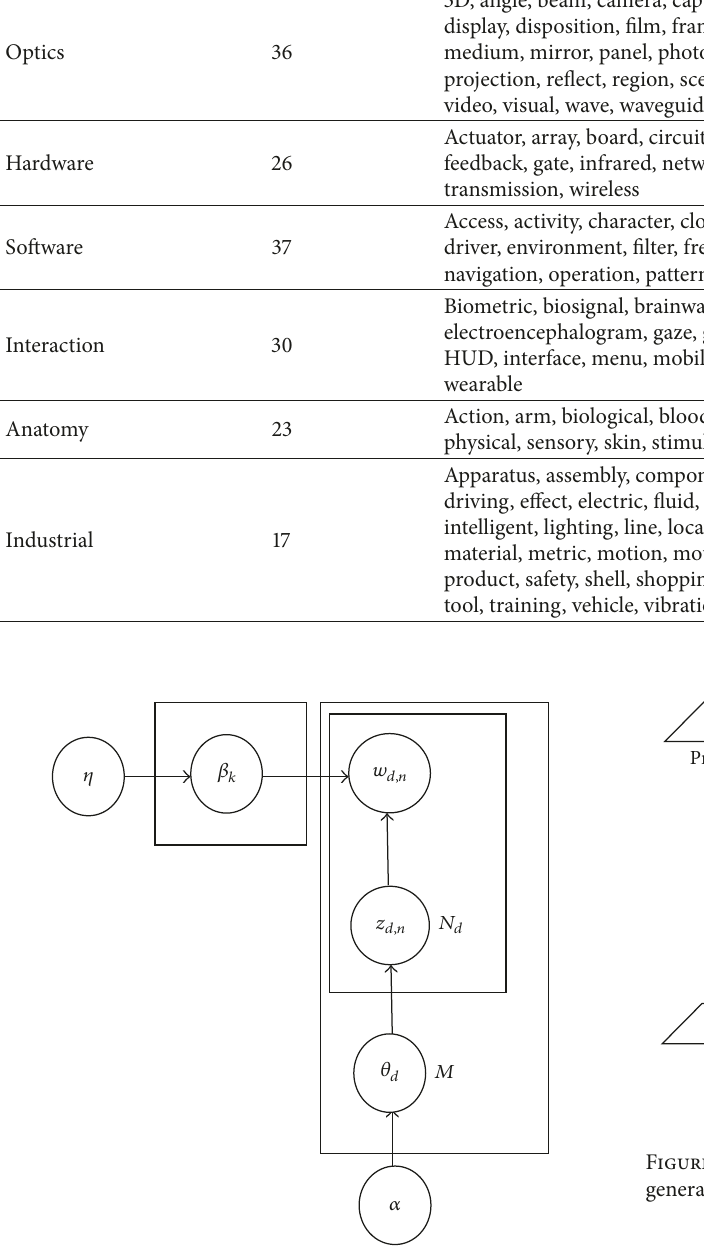
Figure 7: LDA algorithm process model.